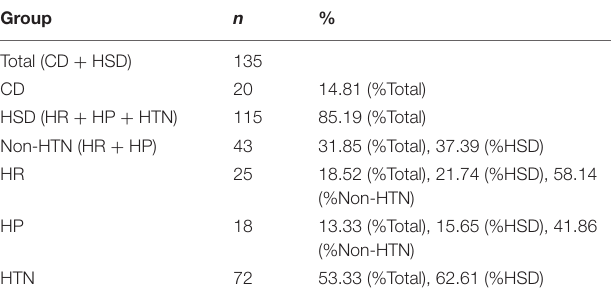
TABLE 2 | Incidence of non-hypertension and hypertension of rats with HSD.